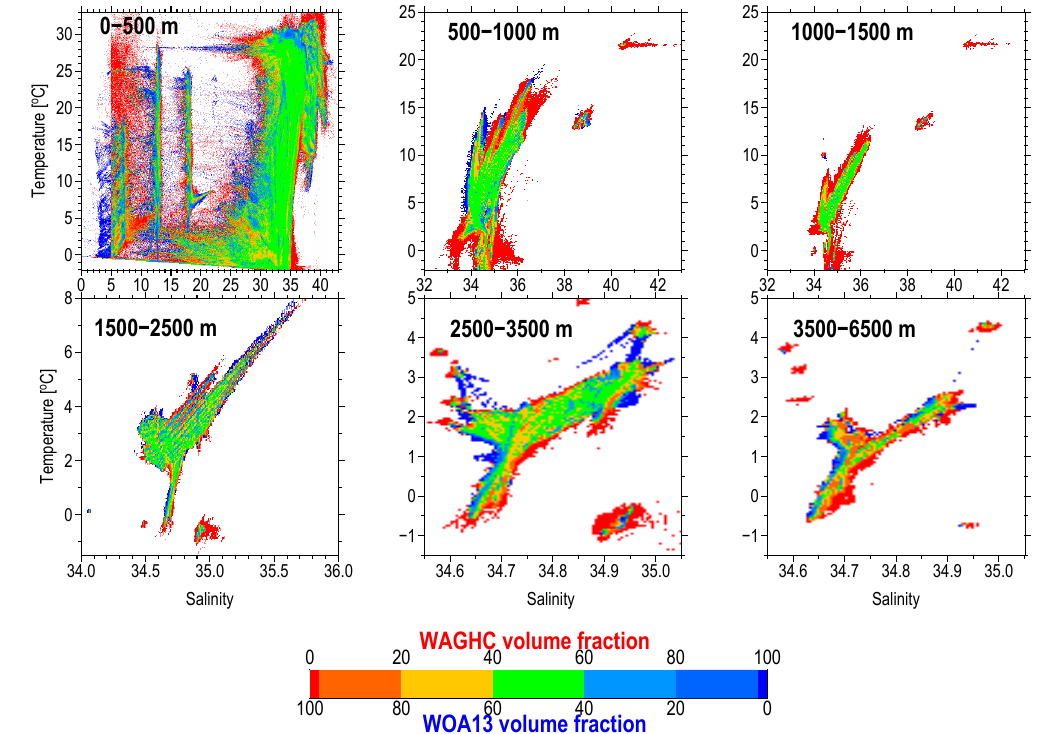
Figure 11. T – S histograms for six depth layers of the world ocean. Bin sizes are 0.05 ◦ C for temperature and 0.005 for salinity. Histograms are based on the gridded WAGHC and WOA13 climatologies. Colors represent the volume fraction of each climatology.